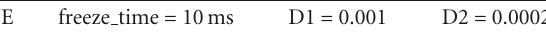
Table 3: Control parameters for the BLUE